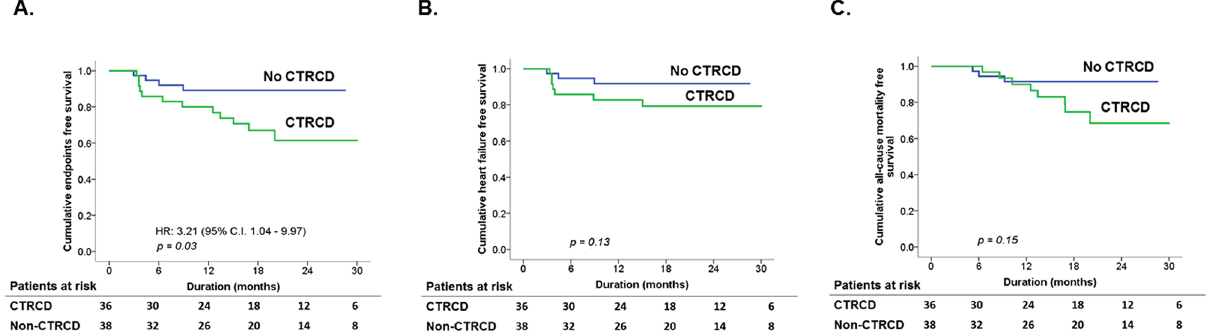
Figure 2. Kaplan–Meier curve of cumulative survival. ( A ) Compared to patients without cancer therapy- related cardiac dysfunction (CTRCD), patients with CTRCD had a significantly higher incidence of the primary endpoint (defined as a composite of all-cause mortality or worsening heart failure events) ( p = 0.03). ( B , C ) There was no significant difference in heart failure events or all-cause mortality between patients with and without CTRCD ( p = 0.13 and 0.15,